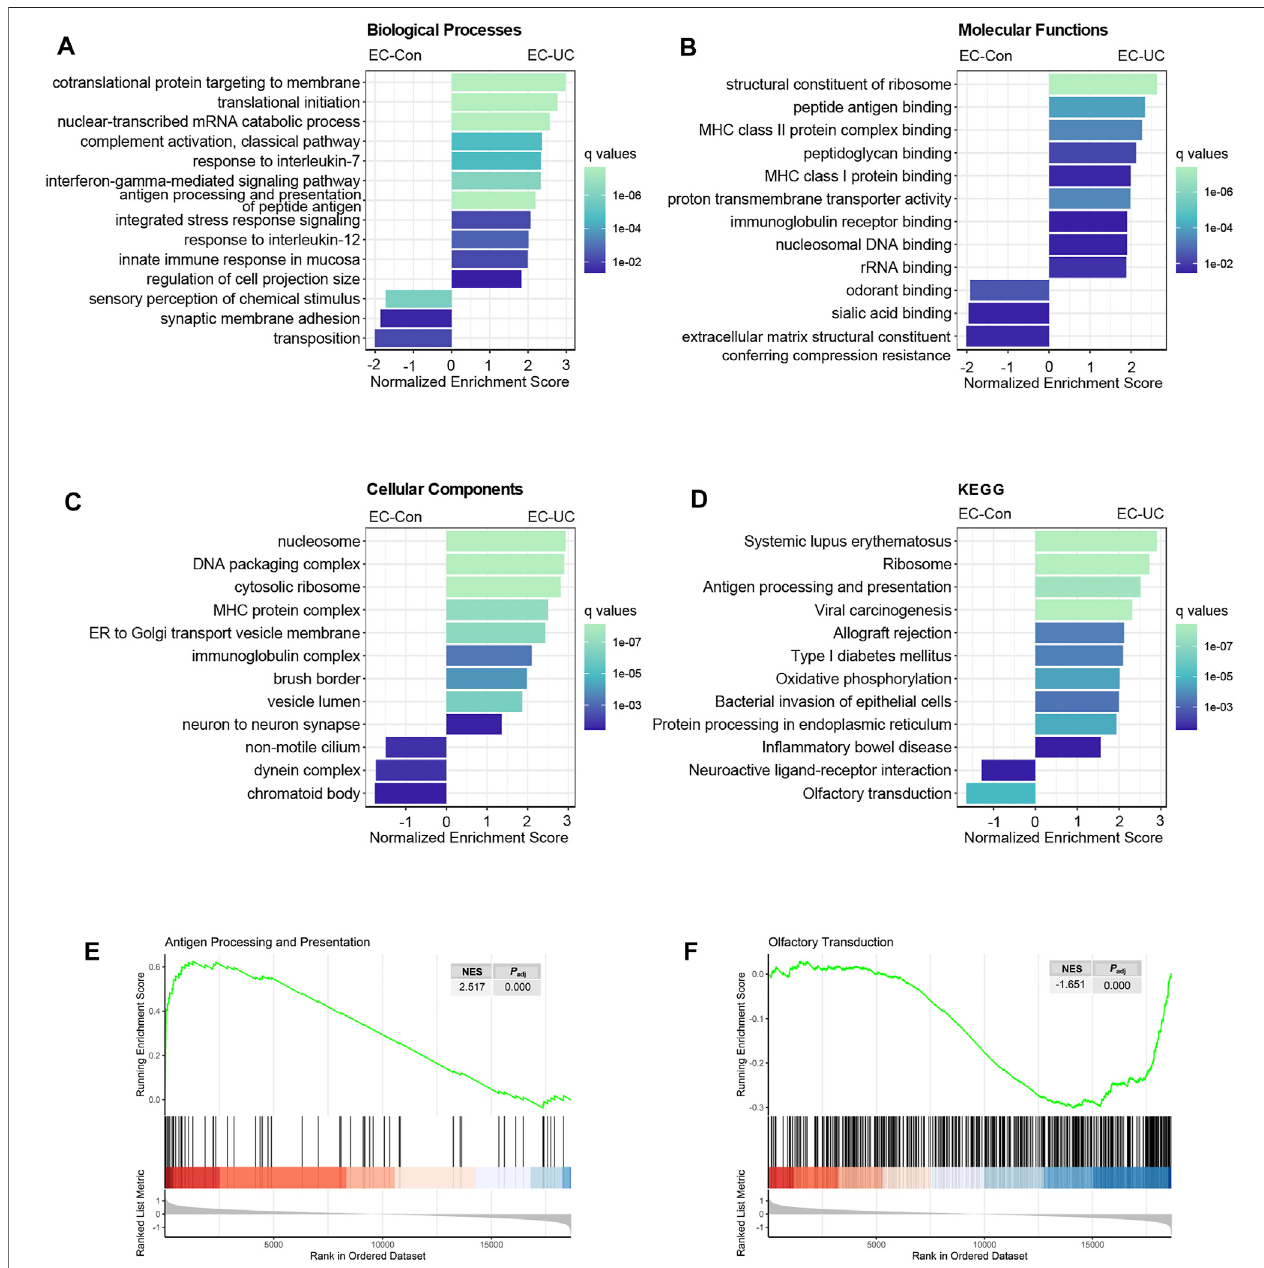
FIGURE5| EnrichmentanalysisrevealingafunctionalshiftofECcellsinpatientswithUC. (A – D) ResultsoftheGSEAcomparingEC-UCandEC-Con.Analysiswas performed using the Gene Ontology categories of biological process (A) , molecular function (B) , and cellular component (C) , and KEGG pathways (D) . The length of each bar indicates the normalized enrichment score, and the color indicates q values of each term. (E,F) GSEA enrichment plot of two KEGG pathways: “ antigen processing and presentation ” and “ olfactory transduction. ” NES, normalized enrichment score. P adj , adjusted p -value.